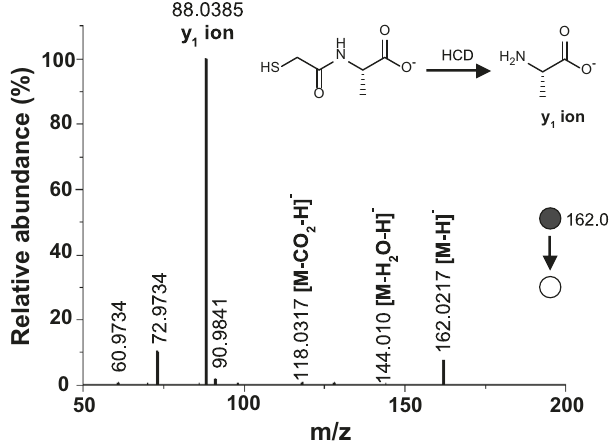
Fig. 4 Dry-down reactions of tg and Ala produce oligomers containing amide bonds. 1 H NMR spectra of: a A fresh, unreacted mixture of thioglycolic acid (tg) with alanine (Ala). b The authentic standard of Ala acylated with tg at the α -amine (tgA) demonstrating the down- fi eld shift of the α -resonance upon amidation of Ala. c Sample of tg dried with Ala in a 5:1 molar ratio at 65 °C for 7 days. The starting tg material contains some thioester-linked dimer (tg) 2 . c(tgA) is the cyclic form of tgA, i.e.,